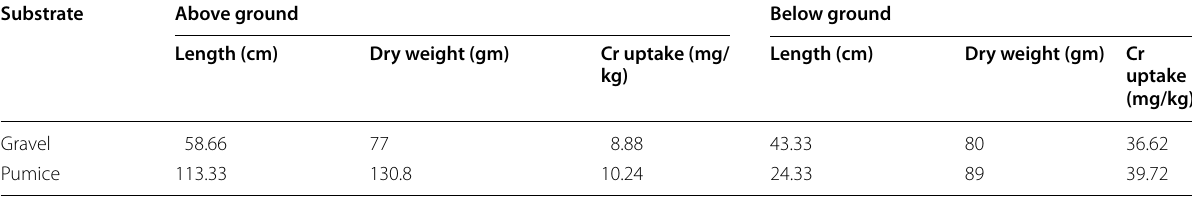
Table 5 Biometry Data of Chrysopogon zizanioides in Gravel and Pumice substrate bed